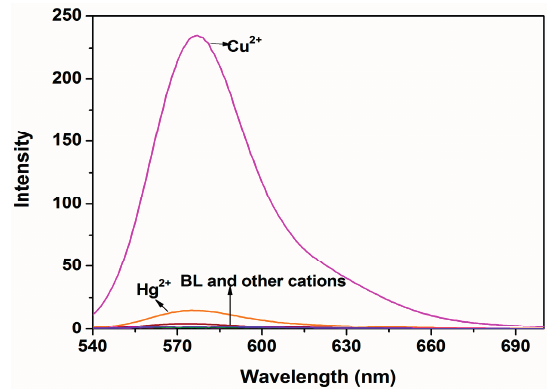
Figure 3. Fluorescence spectra of P (10 μ M) with different metal ions (100 μ M) in ethanol-water solution (9:1, v:v. 20 mM HEPES, pH